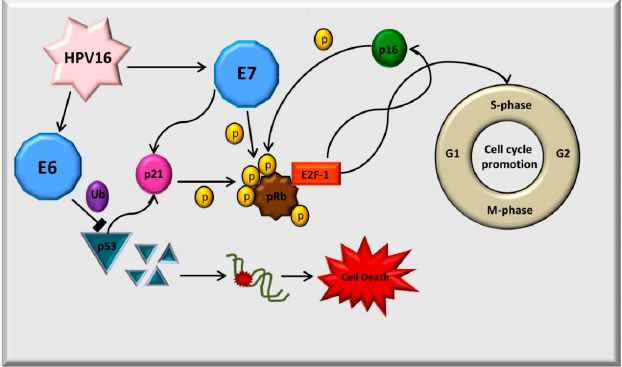
Figure 1. Main molecular mechanisms of oncogenesis induced for E6 and E7 proteins of human papillomavirus 16 (HPV16).